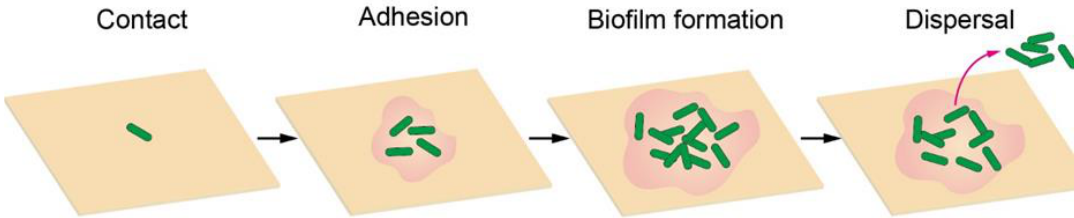
Figure 1. Schematic diagram of bacterial adhesion and biofilm formation process.